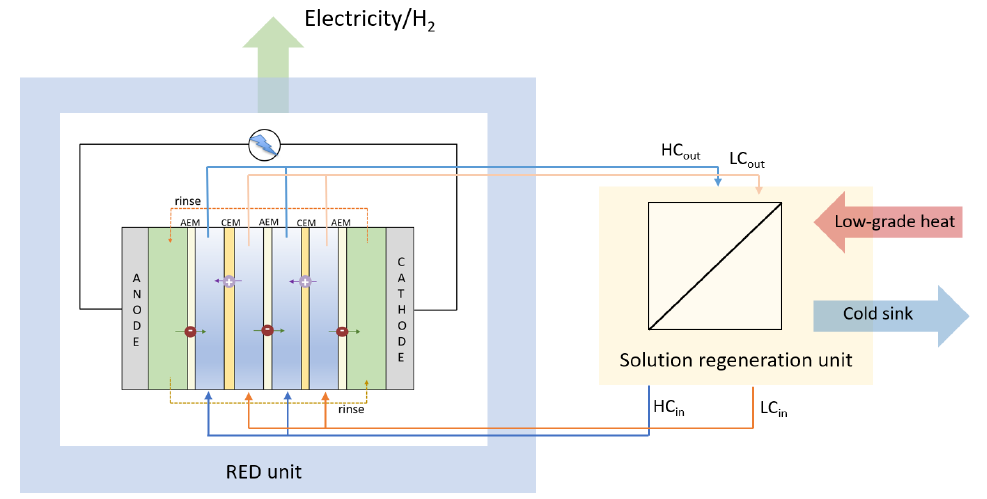
Figure 2. Schematic drawing of a RED Heat Engine, modified from [23]. Low-grade heat is added to the system while withdrawing electricity. High and low-concentration solutions are fed to the RED stack, mixed across AEMs and CEMs to convert their chemical potential into electricity, and then recycled to the solution regeneration unit to restore the initial chemical